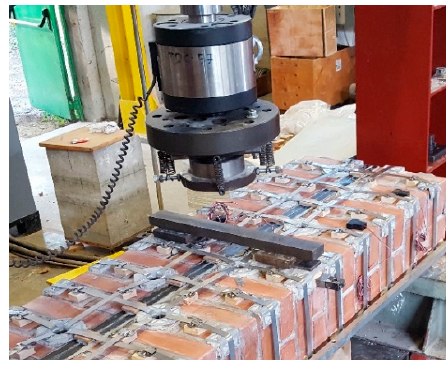
Figure 39. Arrangement of the flat steel bars on the central cross-section.